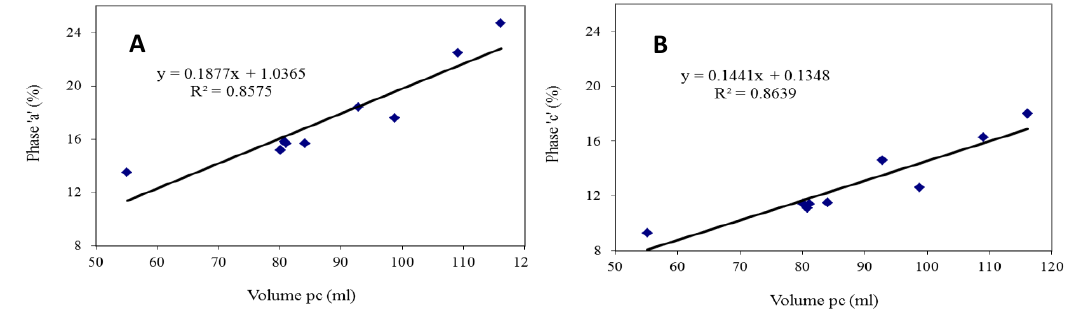
Figure 3. Pulsation chamber volume and length of phases “a” ( A ) and “c” ( B ) ( p < 0.001).